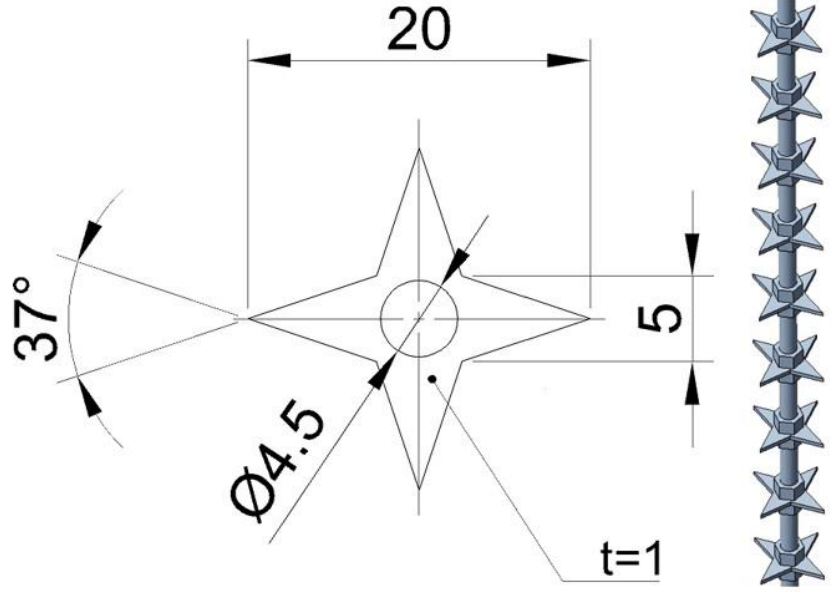
Figure 5. Spike elements for discharging electrode.